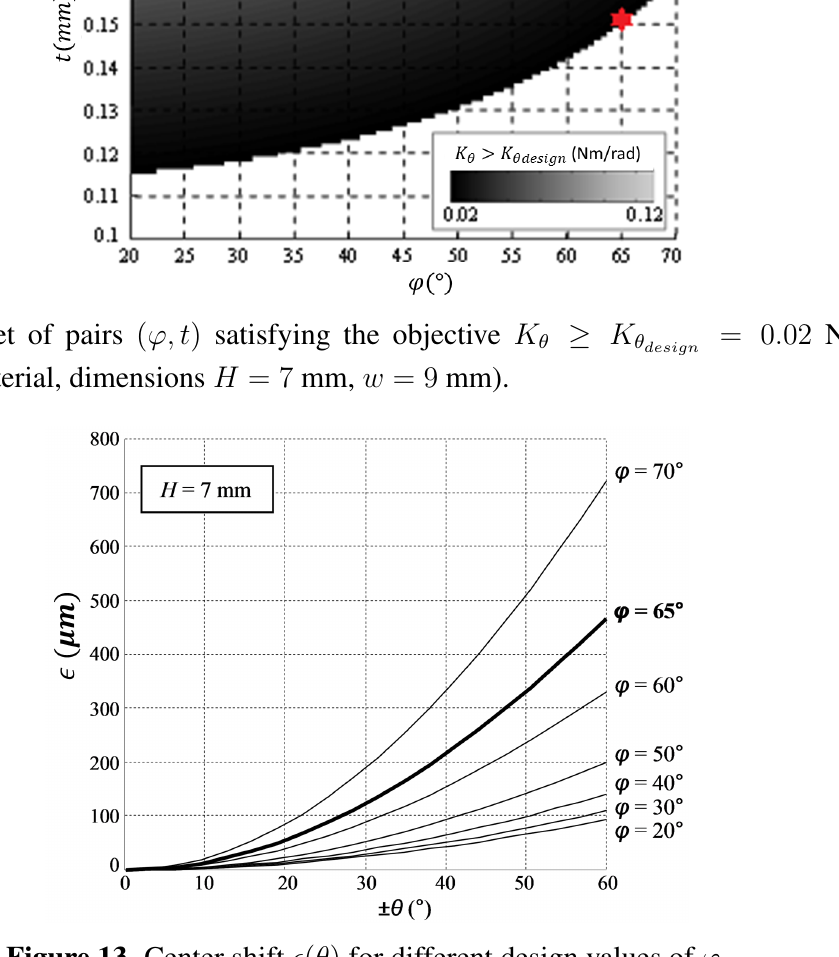
Figure 11. Set of pairs ( ϕ, t ) satisfying the objective | θ material, dimensions H = 7 mm, w = 9 mm).